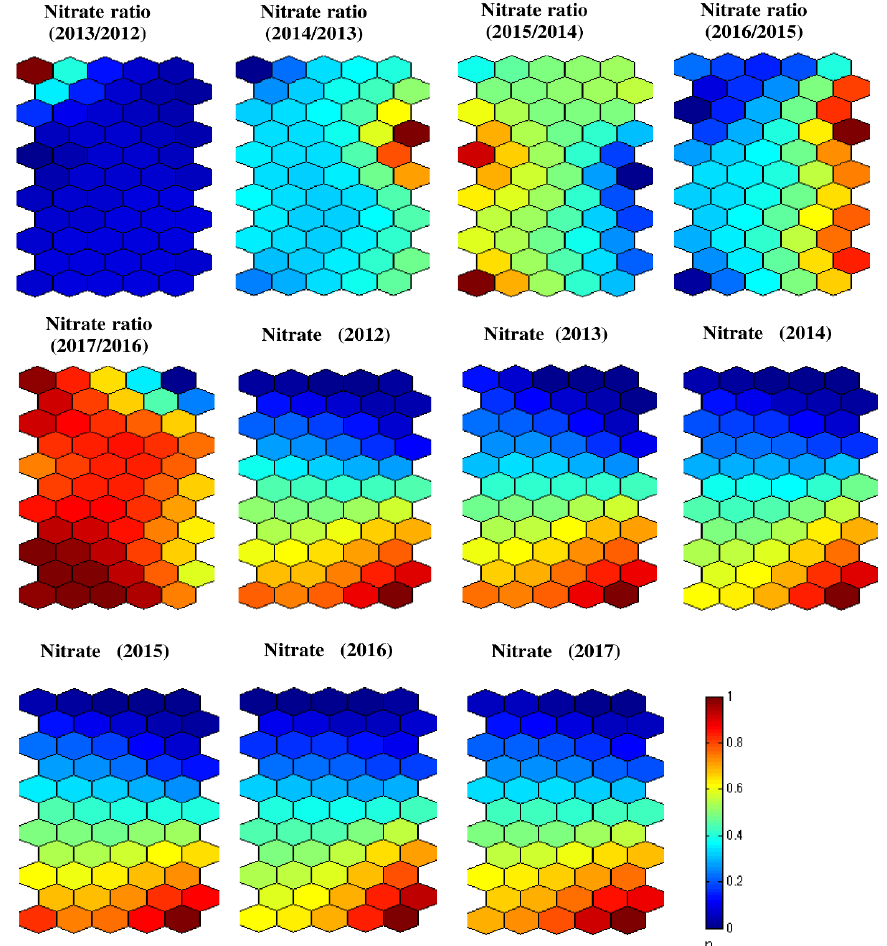
Figure 5. Self-organizing maps (SOM) component planes for 11 nitrate variables.